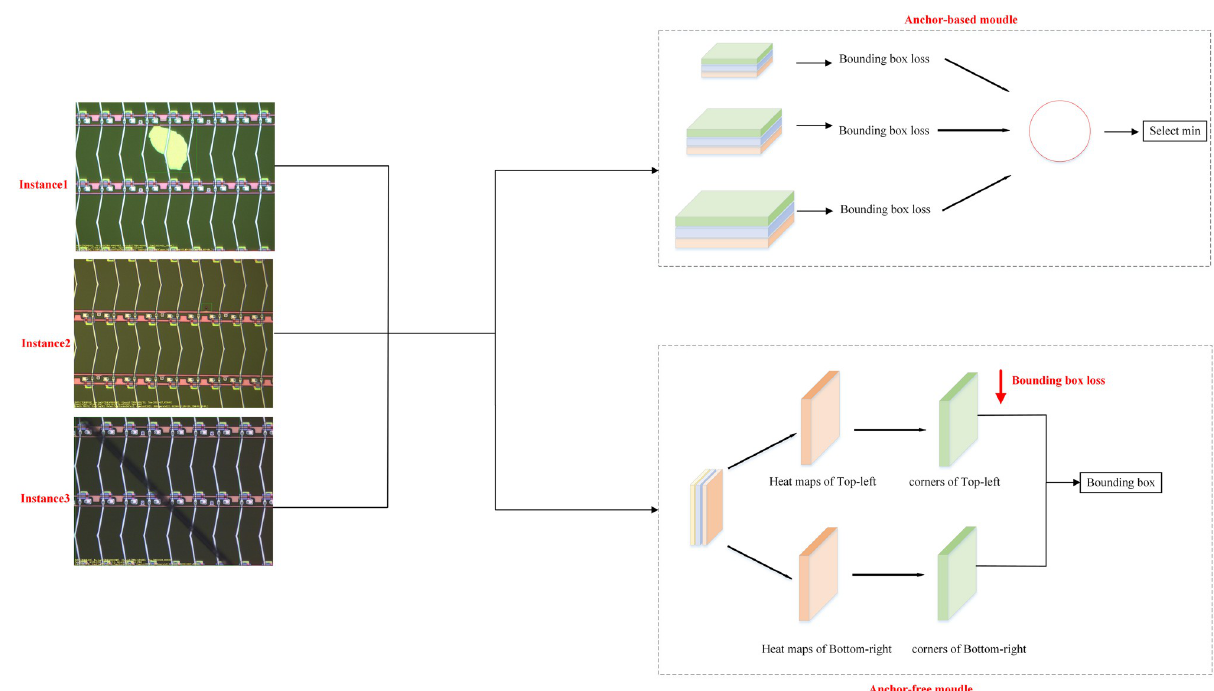
Fig 4. Double branch